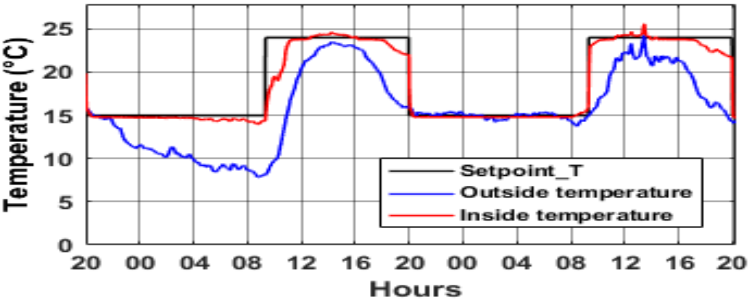
Figure 26. Temperature under ventilation and heating